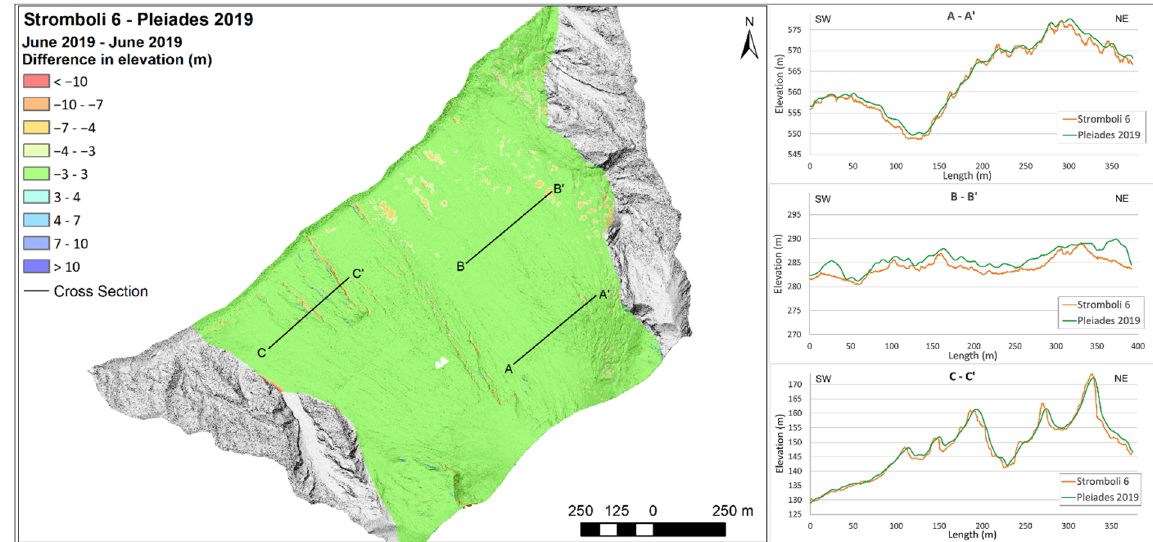
Figure 4. Difference map between the Stromboli 6 aerial photogrammetric survey (carried out in June 2019) and the model generated from the images taken from the PLEIADES ‐ 1 constellation acquired on the same day. On the left side, three cross sections highlighting the correspondence of the two models.